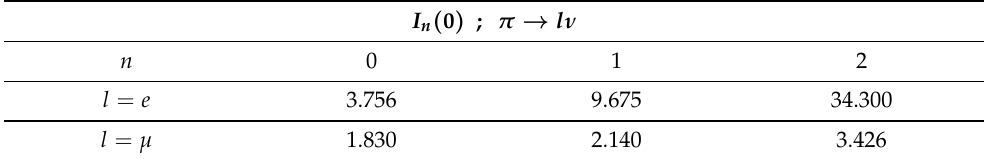
Table 1. Table of limiting values for the function I n ( 0 )